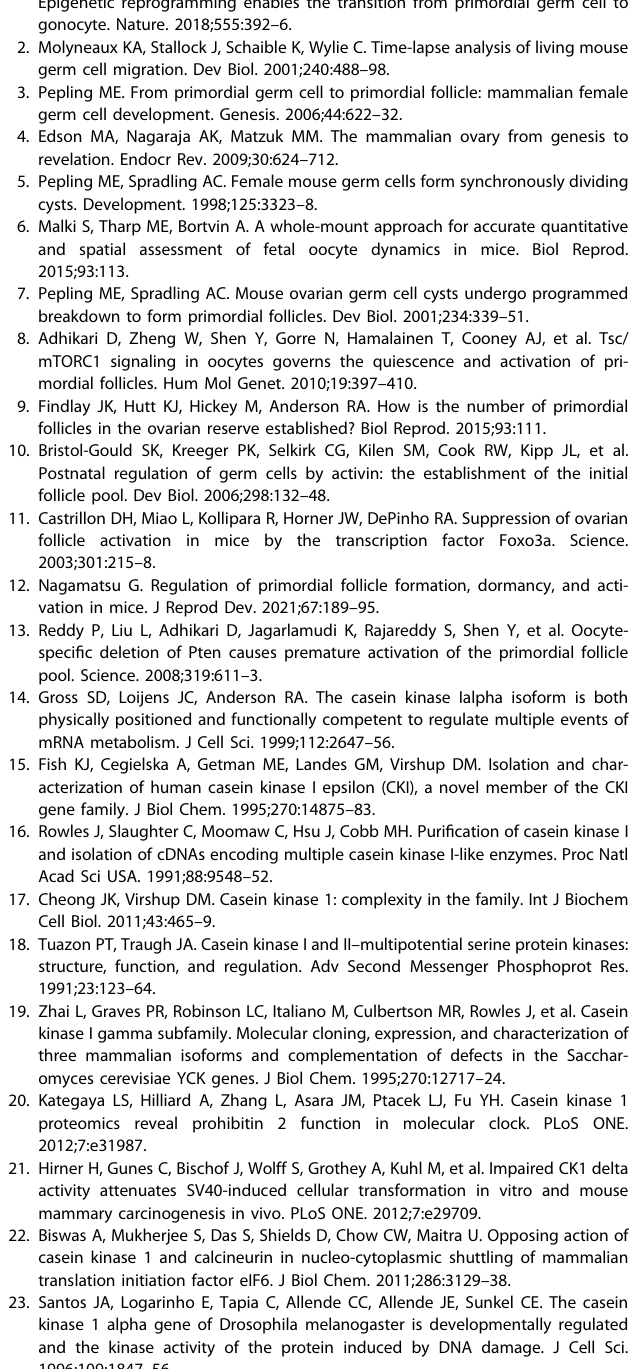
Table S1. The mixture was heated to 95 °C for 10 min, followed by 40 cycles of 95 °C for 15 sec and 60 °C for 1 min. Analyses were conducted in triples, and 2 − ΔΔ Ct method was used to determine gene expression levels. Target genes were normalized to GAPDH as endogenous control. Western blot Ovary Proteins were extracted with RIPA buffer (50 mM Tris-HCl, pH 7.4, 150 mM NaCl, 1% Triton X-100, 1% sodium deoxycholate and 0.1% sodium dodecyl sulfate (SDS)) containing 1 mM phenylmethylsulphonyl fl